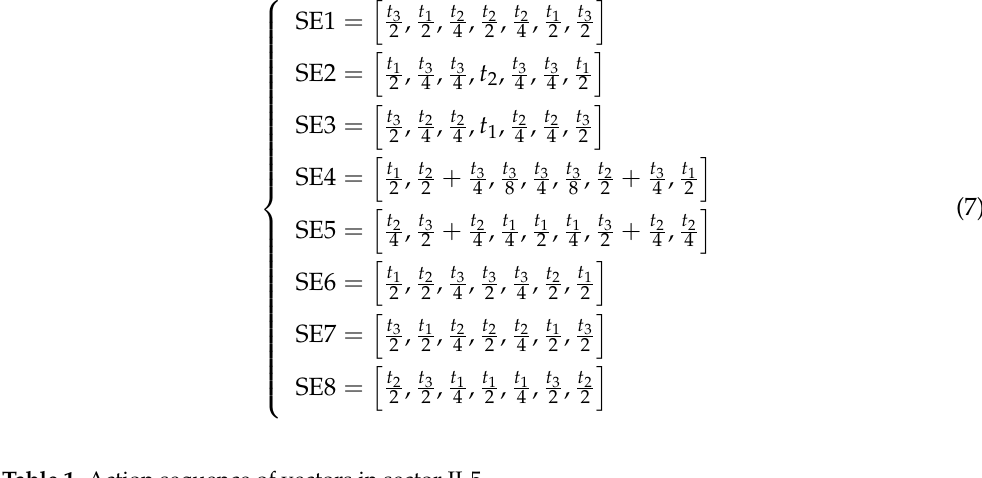
Table 1. Action sequence of vectors in sector